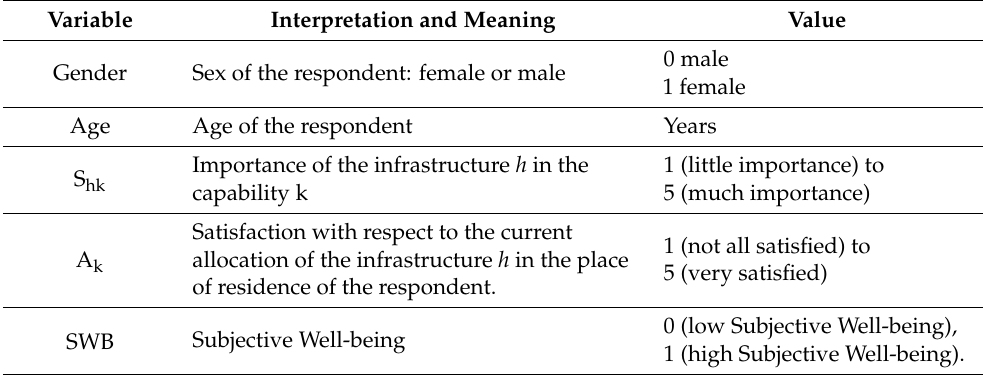
Table 2. Description of variables used in the econometric